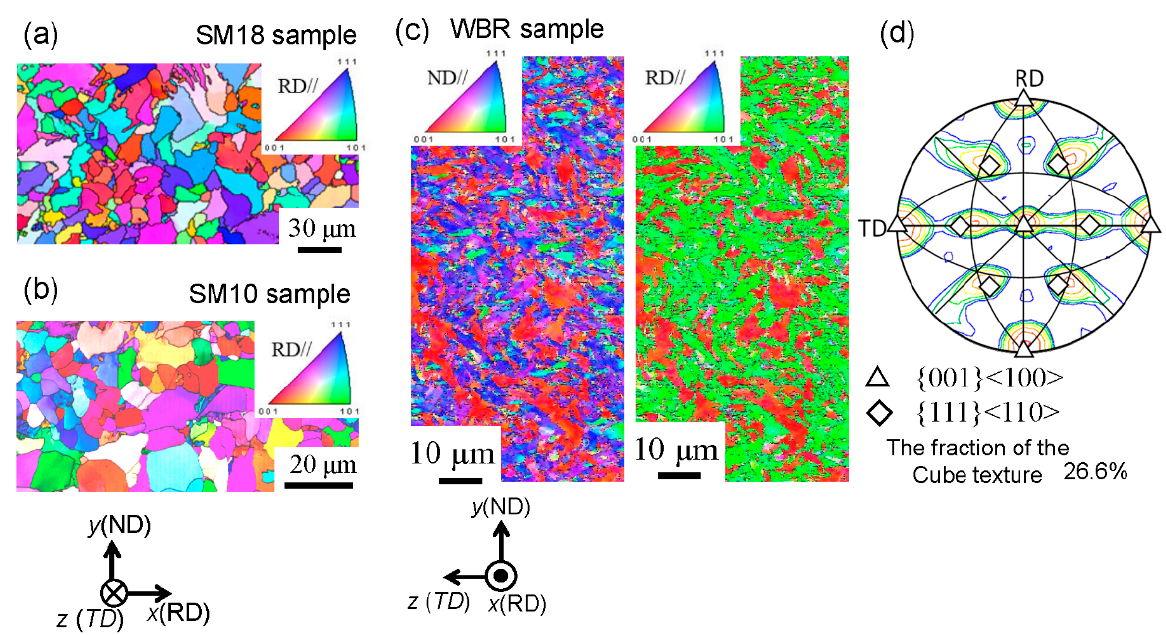
Figure 5. Orientation maps along the RD on the cross-sectional plane parallel to the RD at the center for ( a ) the SM18 sample and ( b ) the SM10 sample. Orientation maps along the RD and normal direction (ND) on the cross-sectional plane( c ) normal to the RD at the center for the WBR sample, and ( d ) the (100) pole figure.